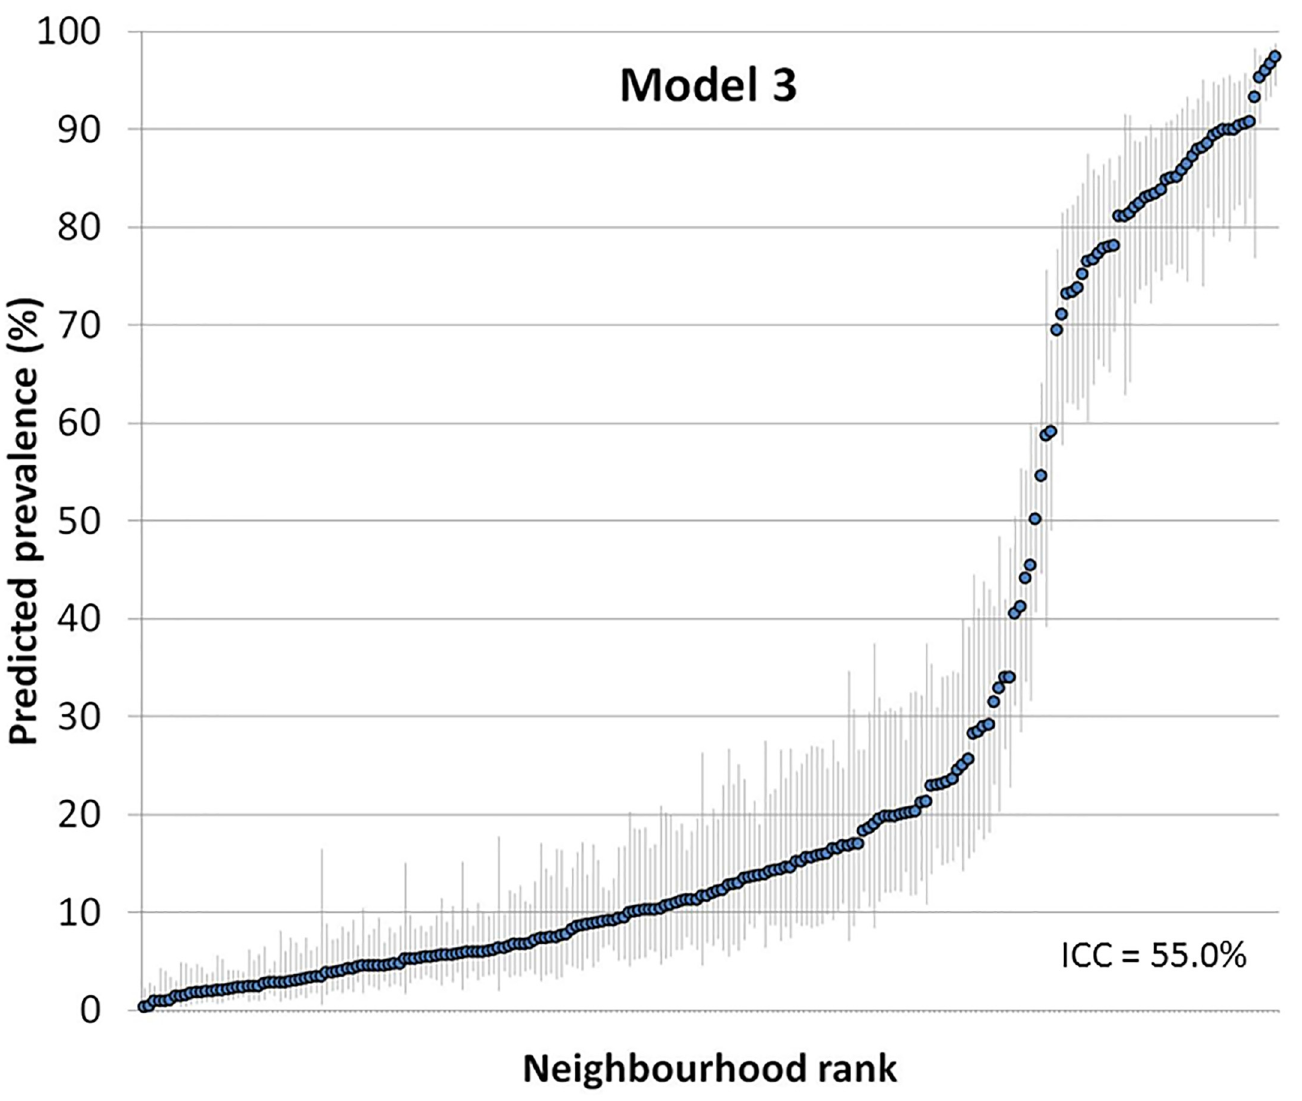
Fig 6. Predicted prevalence of using a private physician in each neighborhood with 95% confidence intervals versus ranking. Predictions are for the reference individual in model 3, i.e., female, age 35 – 39, low income and living in a low income